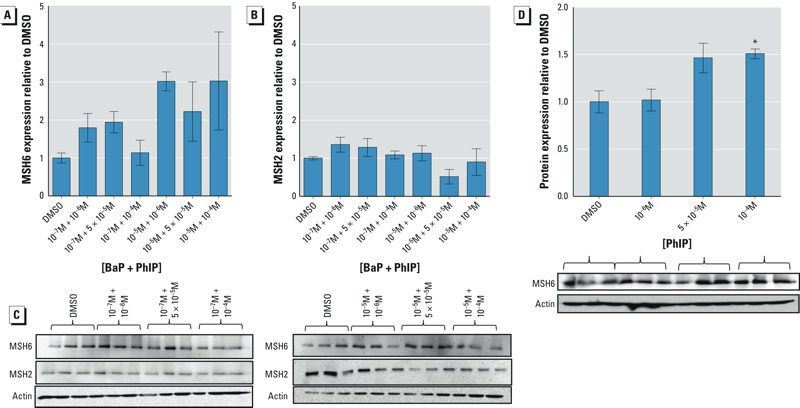
Effects of mixtures of BaP and PhIP, or PhIP alone, on mismatch-repair proteins. Effects of a 24-hr treatment with selected concentrations of mixtures of BaP (stated first) and PhIP on the expression of (A) MSH6 or (B) MSH2. (C) Representative immunoblots showing the abundance of MSH6 and MSH2 proteins. (D) Effects of a 24-hr treatment with selected concentrations of PhIP on MSH6 protein expression. The intensity of each protein in DMSO-treated cells was used as a reference after correcting for loading (β-actin). Data are presented as the mean ± SEM, n = 3. Significance compared with the DMSO control calculated using one-way ANOVA with Dunnett’s post-test (*p ≤ 0.05).